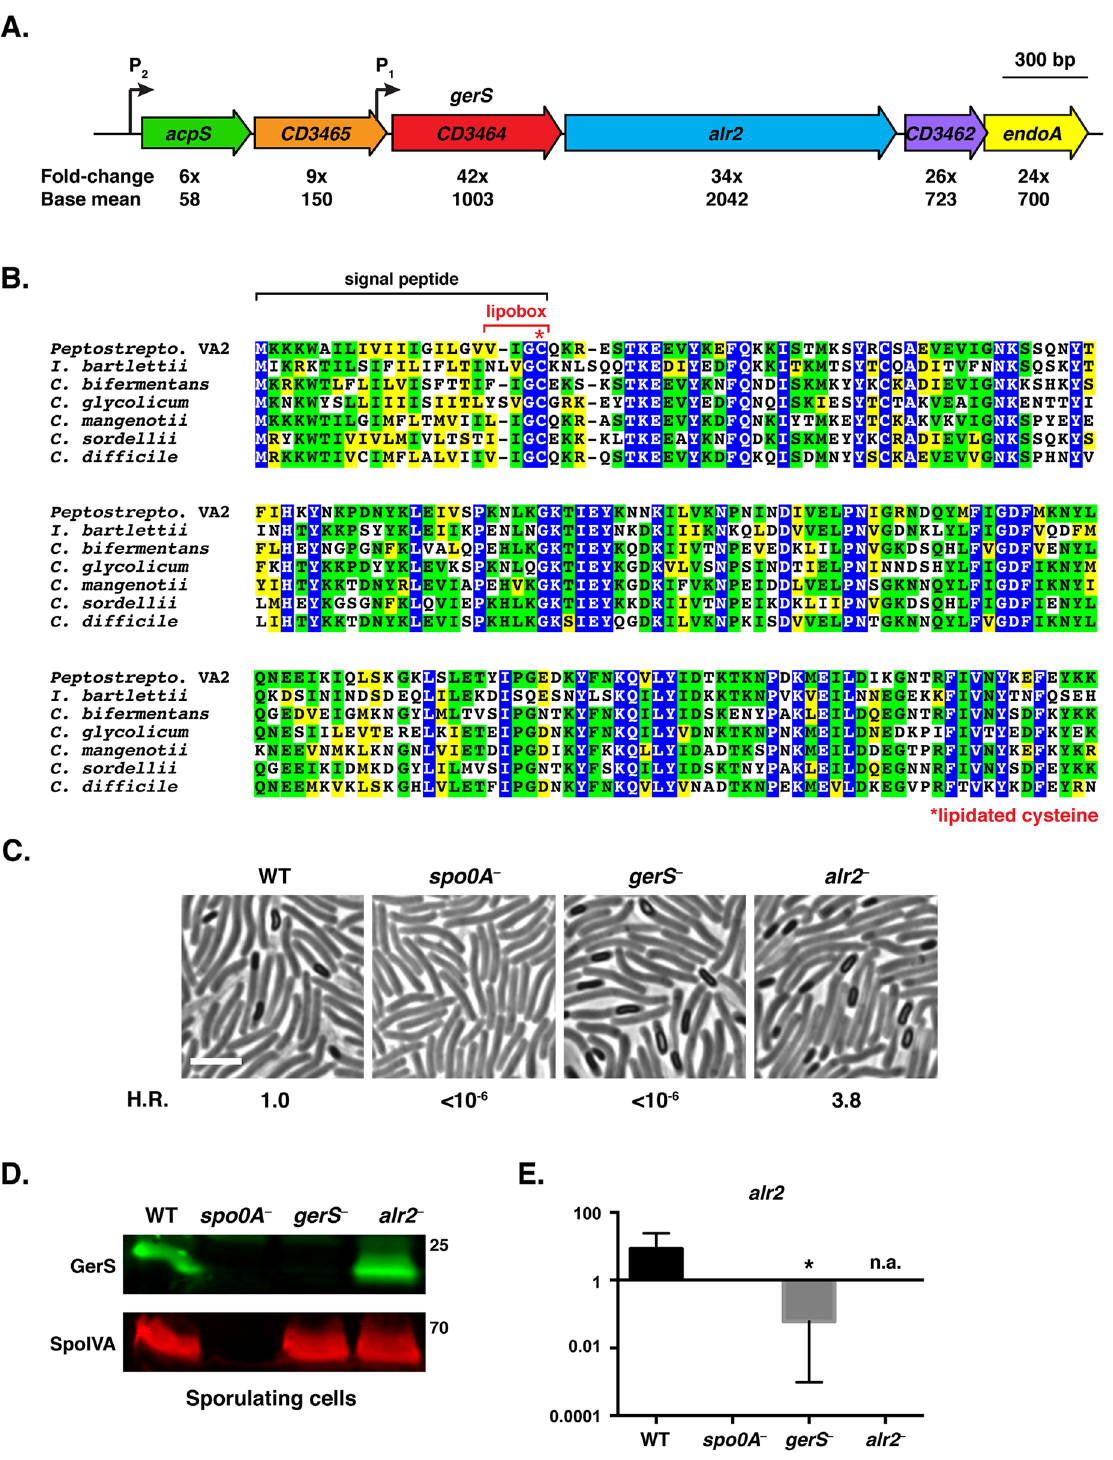
Fig 1. C . difficile gerS is highly induced during sporulation and encodes a protein important for heat-resistant spore formation. (A) Schematic of C . difficile gerS and alr2 genomic loci. gerS and alr2 are predicted to be part of an operon where transcription initiates from a P 1 promoter immediately upstream of gerS (mapped by RNA-Seq transcriptional start site mapping, [42]) and potentially from the P 2 promoter upstream of acpS . Fold-change represents the difference in gene expression between wild type and the sigE − mutant [41]. Base mean refers to the number of transcripts detected for the respective gene normalized to the length of that gene. (B) ClustalW alignment of GerS. Completely conserved, identical residues are blocked in blue, conserved identical